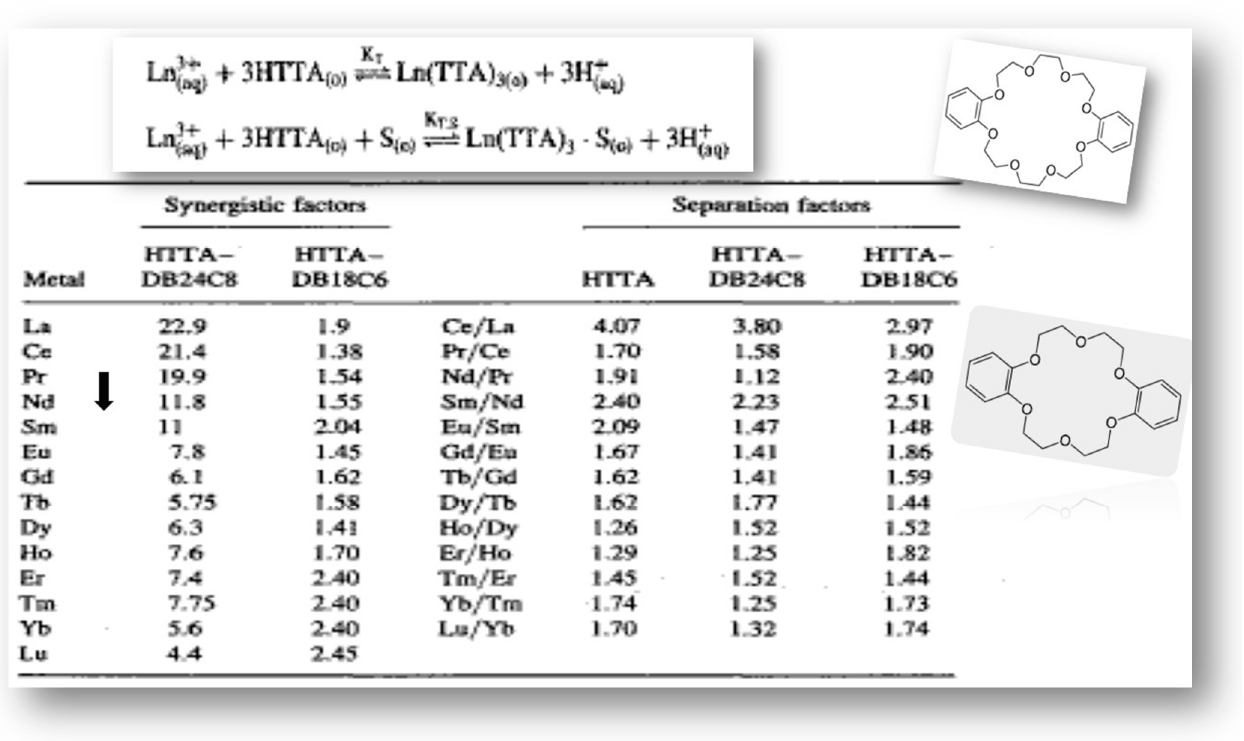
Figure 7. Values of the synergistic and separation factors in the 4f-series produced by HTTA, HTTA − DB24C8, and HTTA − DB18C6 solvent systems in 1,2-dichloroethane, ([HTTA] = 6 × 10 − 2 mol/dm 3 , [DB24C8(DB18C6)] = 2,5 × 10 − 3 mol/dm 3 , pH = 3,80). Adaptation from Ref. [105]. ©2005 Taylor&Francis.